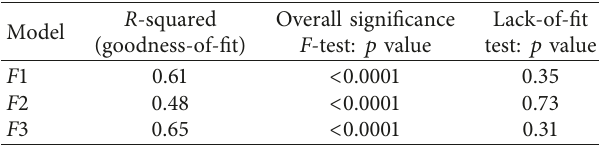
Figure 2: Biplots resulting from the principal component analysis (PCA). Table 4: Summary of the models developed: statistical